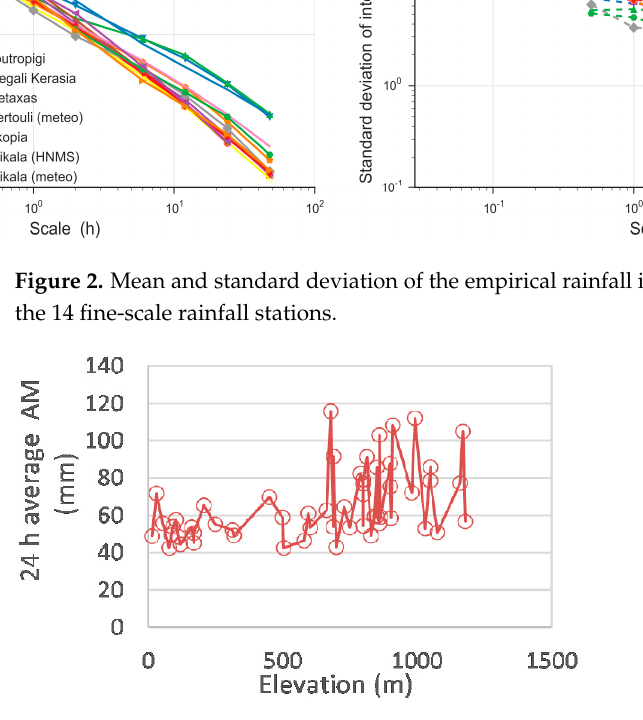
Figure 3. Average annual rainfall maxima (mm) at the 24 h scale vs the stations’ elevation.